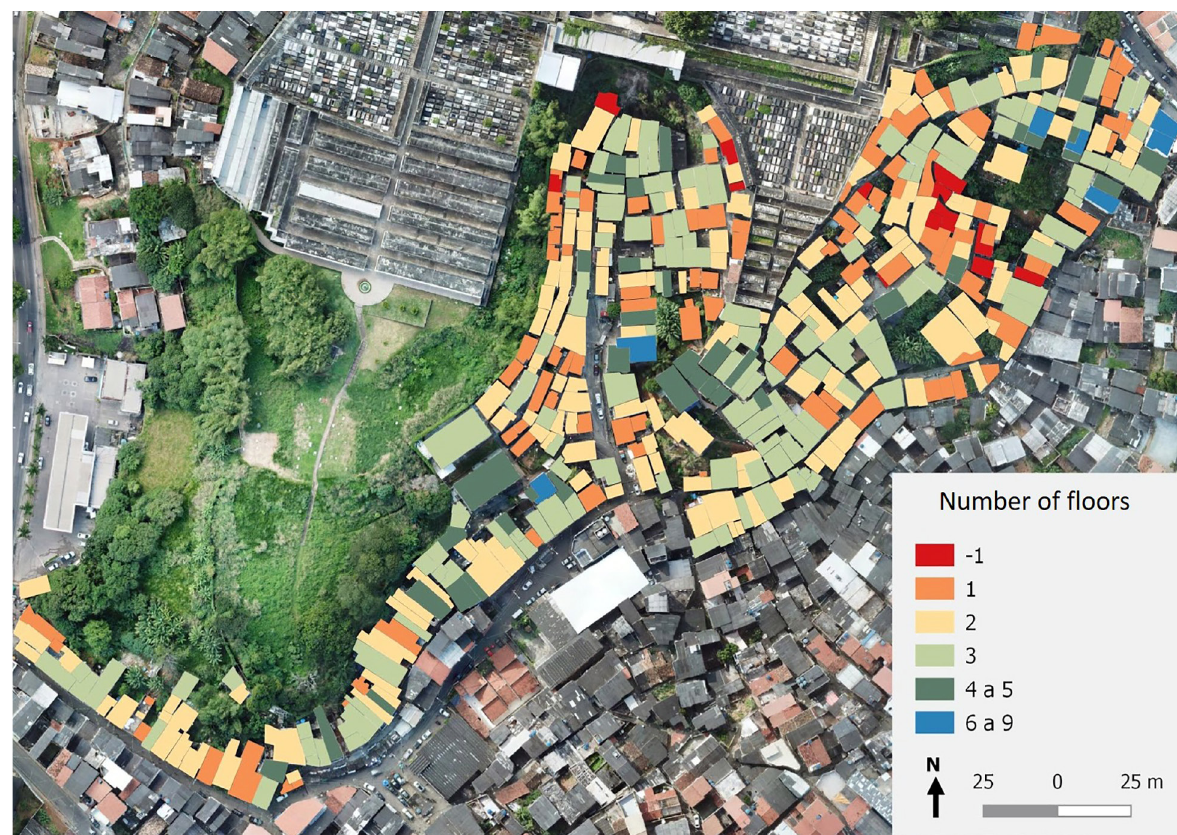
Fig. 6. Spatial patterns of buildings distributed by the number of floors, Alto das Pombas